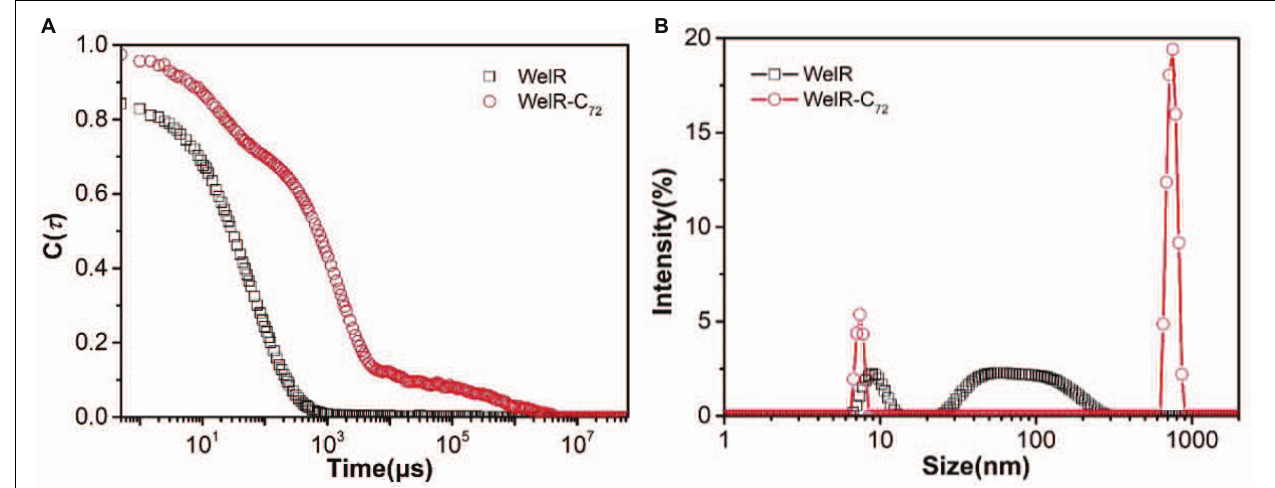
FIGURE 4 | DLS intensity autocorrelation function (A) and size distribution by intensity (B) of WelR and WelR-C 72 . The concentration of WelR and WelR-C 72 was about 100 µ g/mL.